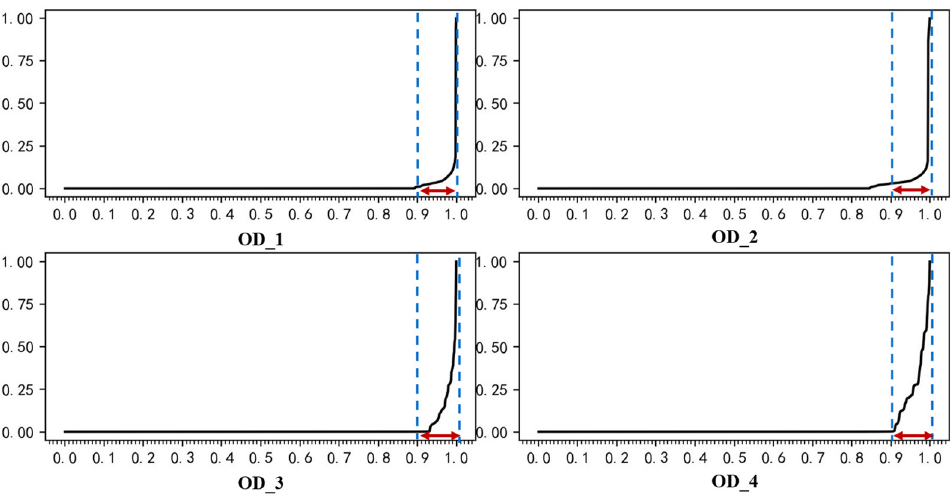
Figure 5. Distribution of travel time of individual ODs.